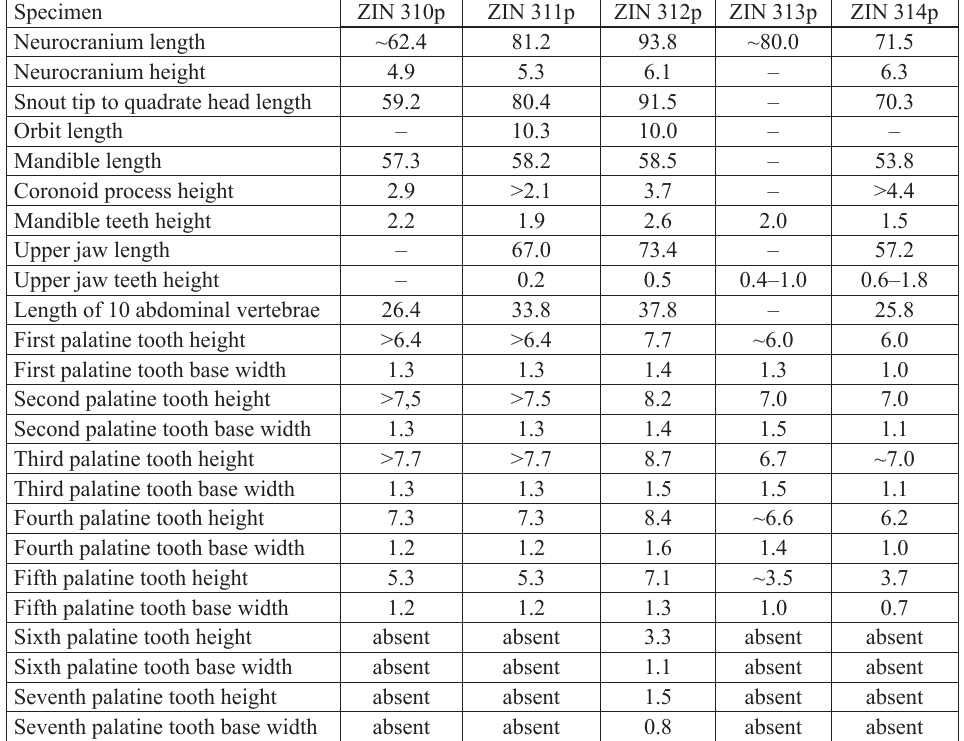
Table 1. Measurements (in mm) of the specimens of Polymerichthys sp. from the Cenozoic of Sakhalin.